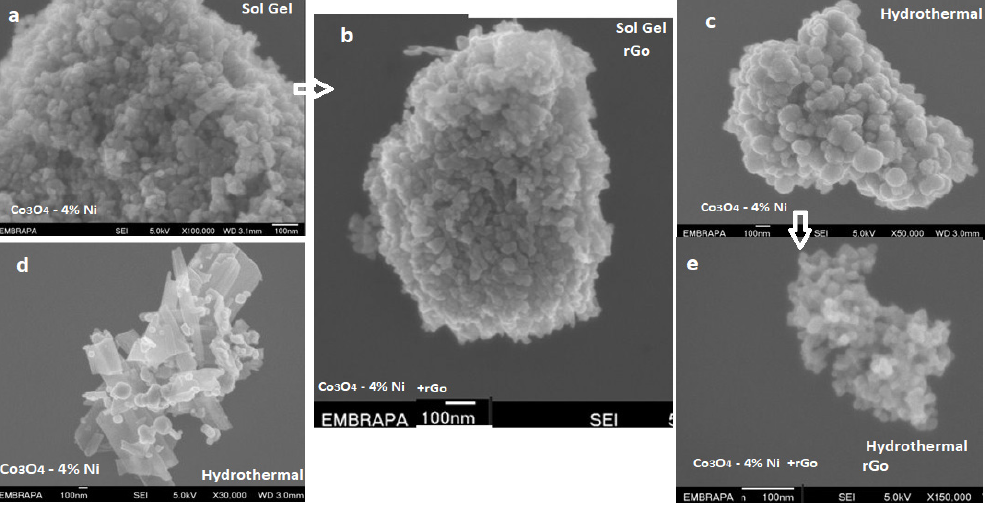
Figure 3. FESEM images of Co 3 O 4 doped at 4% Ni: ( a ) Co 3 O 4 -4%Ni SG , ( b ) Co 3 O 4 -4%Ni+rGO SG , ( c ) Co 3 O 4 -4%Ni HT (Method 1) , ( d ) Co 3 O 4 -4%Ni HT (Method 2), and ( e ) Co 3 O 4 -4%Ni+rGO HT.